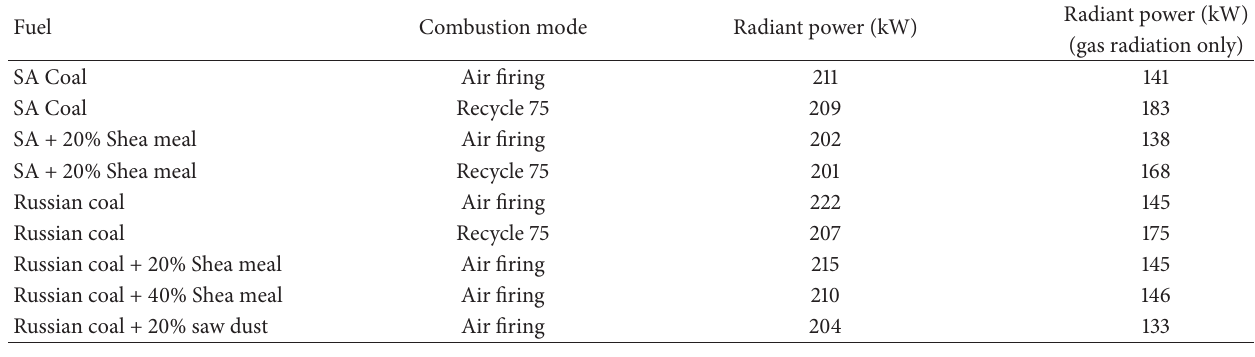
Table 4: Radiant power of the different flames estimated by employing variable particle radiative properties in the simulations.